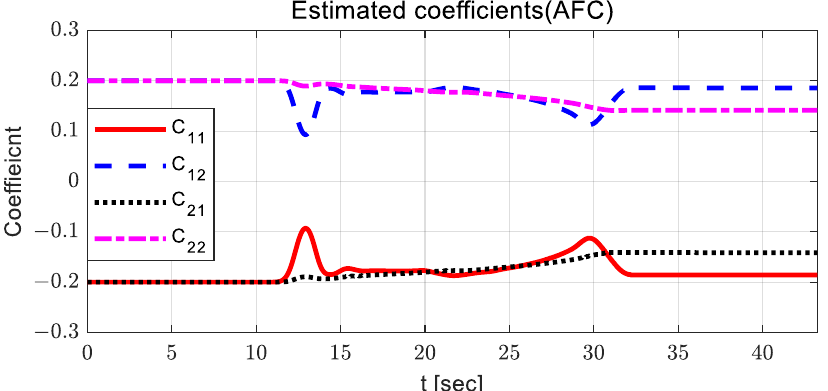
Figure 6. Results: estimated coefficients in the case of AFC for the curved path tracking.